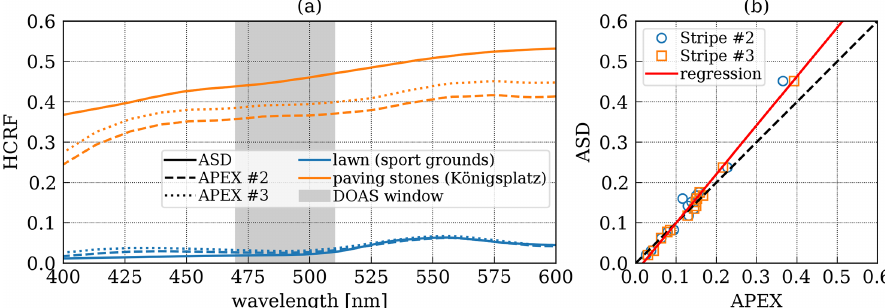
Figure 7. (a) APEX and ASD HCRF spectra for a dark and bright surface. (b) Scatter plot comparing APEX and ASD at 490nm over all 14 targets. The regression line has a slope of 1.211 and an intercept of − 0 . 022. The correlation coefficient is 0.99.